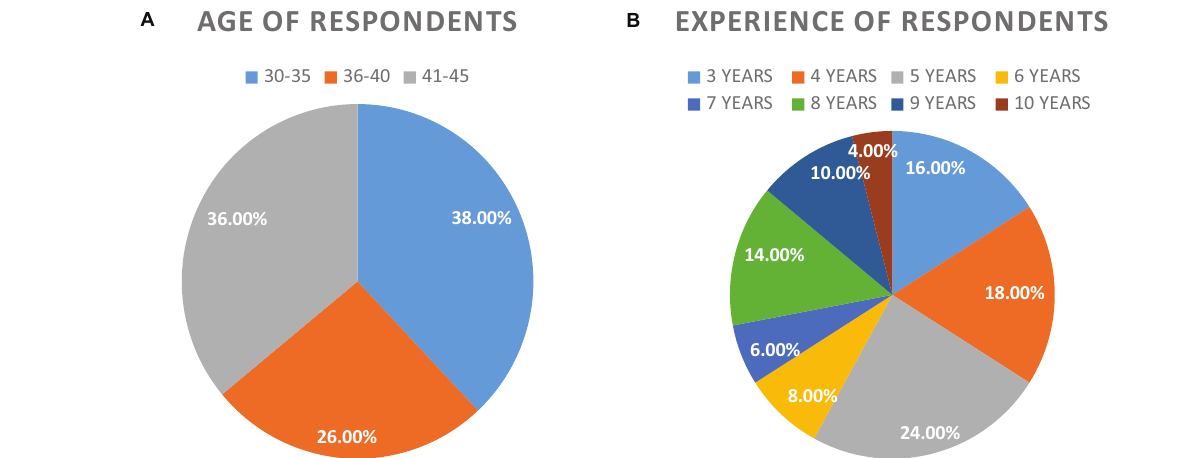
FIGURE 4 | Analysis of respondents in terms of age/experience.